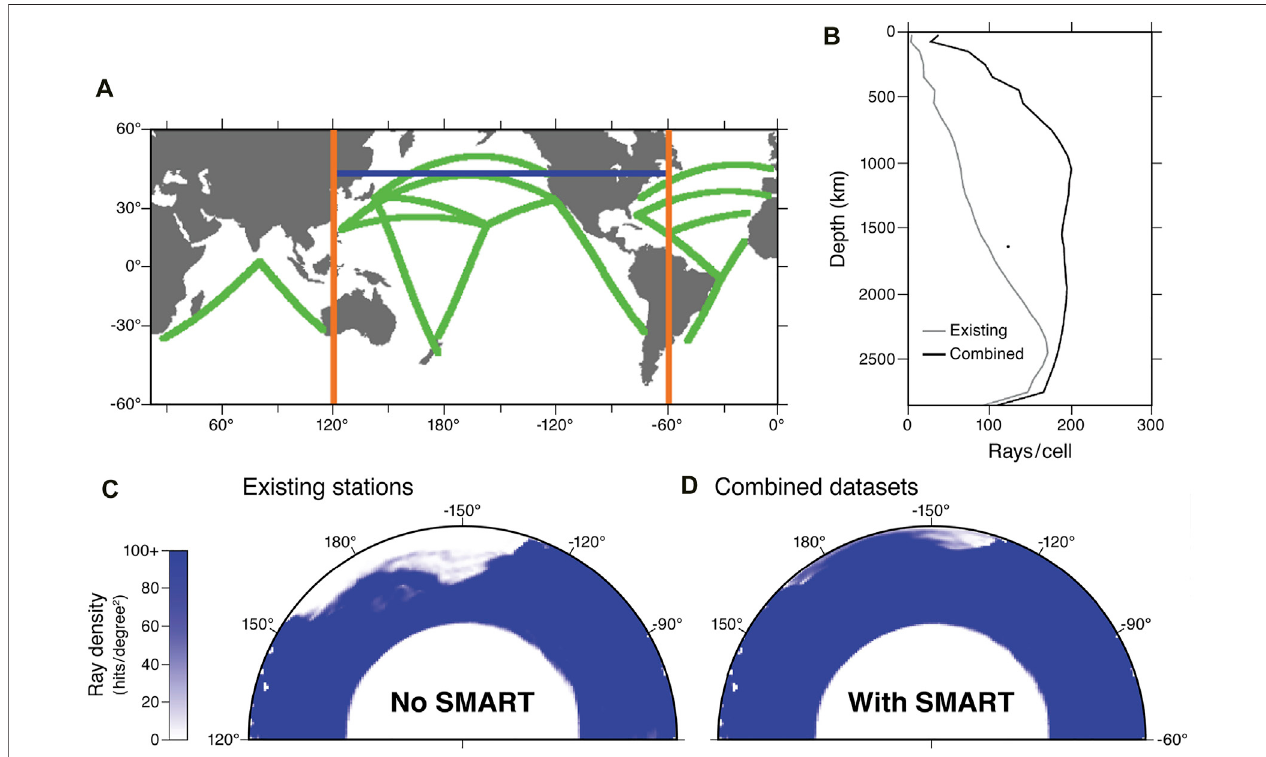
FIGURE 3 | (A) Notional SMART cable routes. (B) Comparison of coverage for seismic paths sampled beneath the northern Paci fi c Ocean, for existing stations (grayline)versusadditionofnotionalSMARTCables(black).Thecurvesrepresentthematerialvolumeinwhicheach1 ° × 1 ° x100 kmdepthelementissampledbymore than 100 rays. Horizontal axis represents units of 10 5 cubic kilometers (Ranasinghe et al., 2018). (C,D) Example of ray path coverage (hit counts) for 1 × 1 degree x 100 kmdepthvolumesinnorth-centralPaci fi c,for (C) existingstationcoveragevs. (D) combinedexistingstationsandSMARTcablesforthesectionindicatedwith a blue line in (A) . This modeling was undertaken using the global ak135 Earth model. Color scale saturates at 100 rays per volume